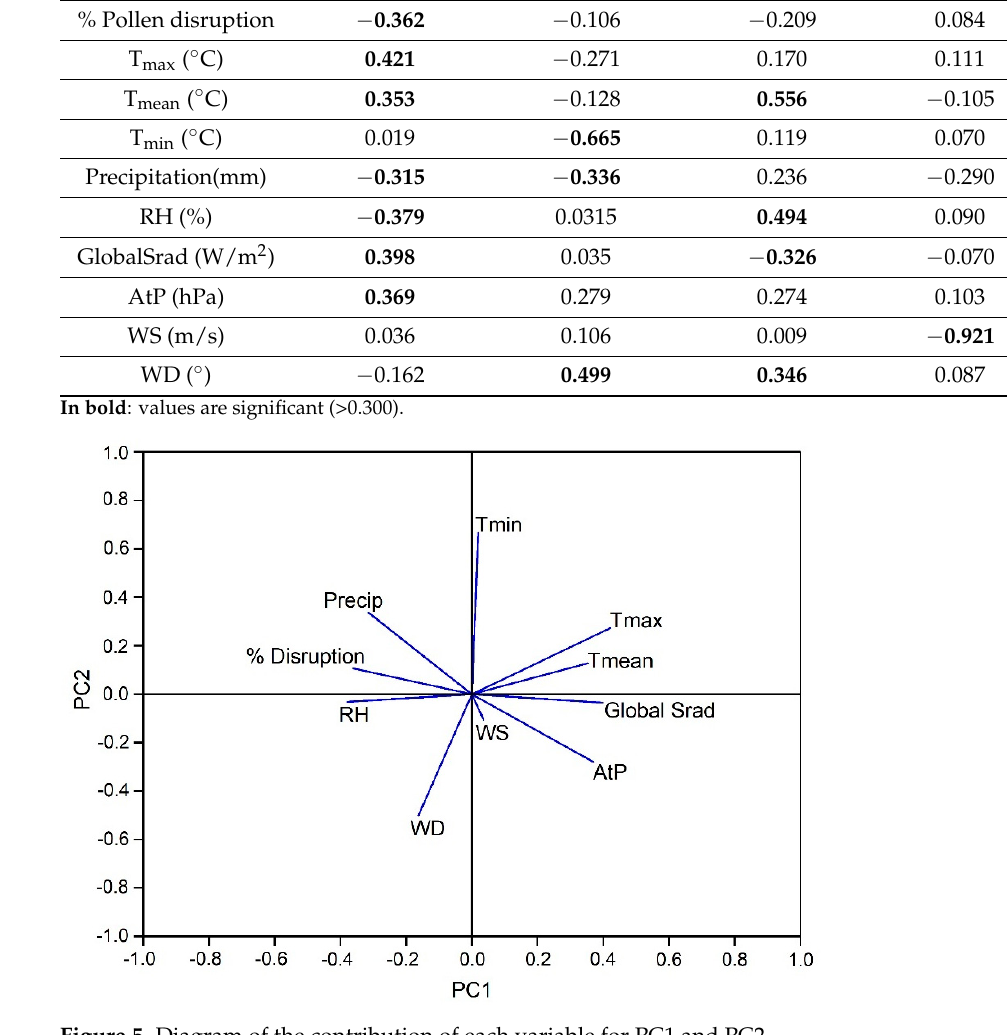
Figure 5. Diagram of the contribution of each variable for PC1 and PC2.